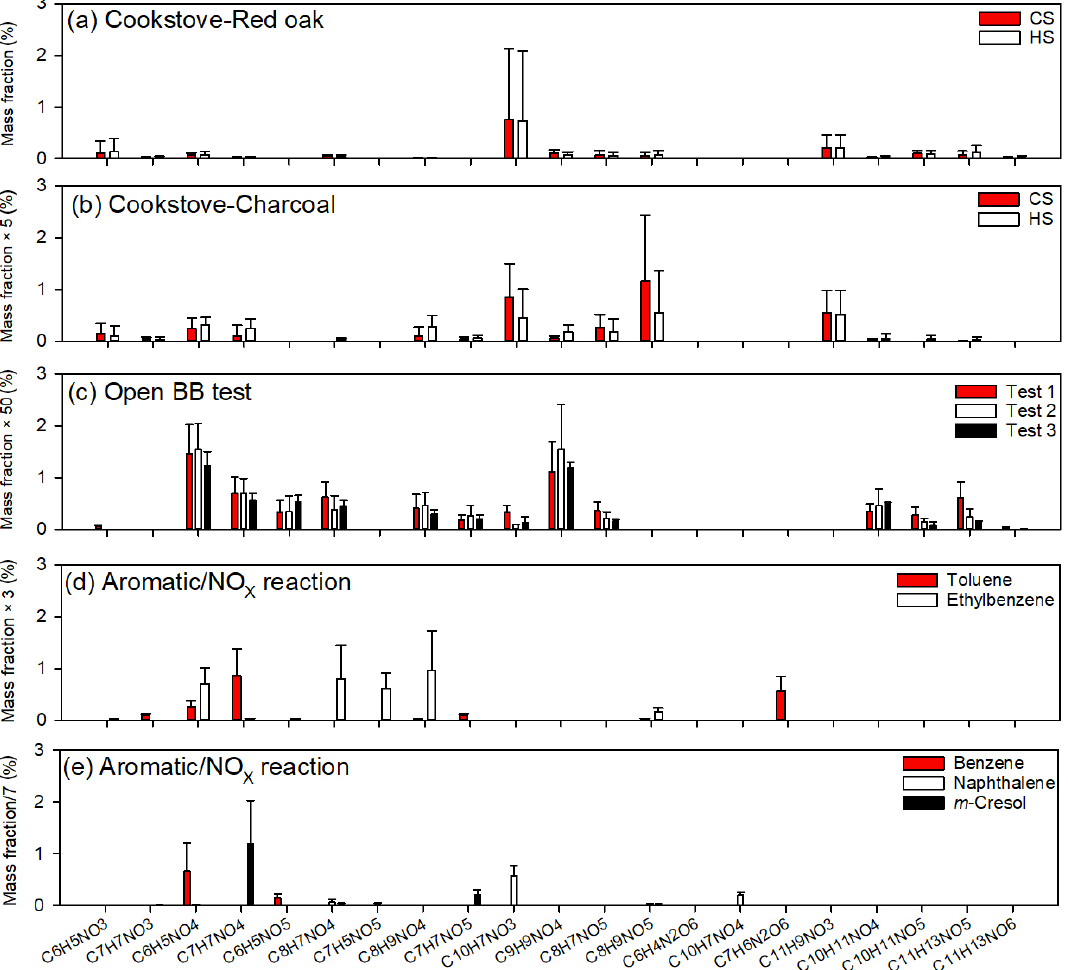
Figure 2. Average mass ratios (%) of individual NACs to organic matter from (a) red oak burning in cookstoves; (b) charcoal burning in cookstoves; (c) open BB experiments (Xie et al., 2019); and photochemical reactions of (d) toluene and ethylbenzene and (e) benzene, naphthalene, and m-cresol with NO x (Xie et al.,